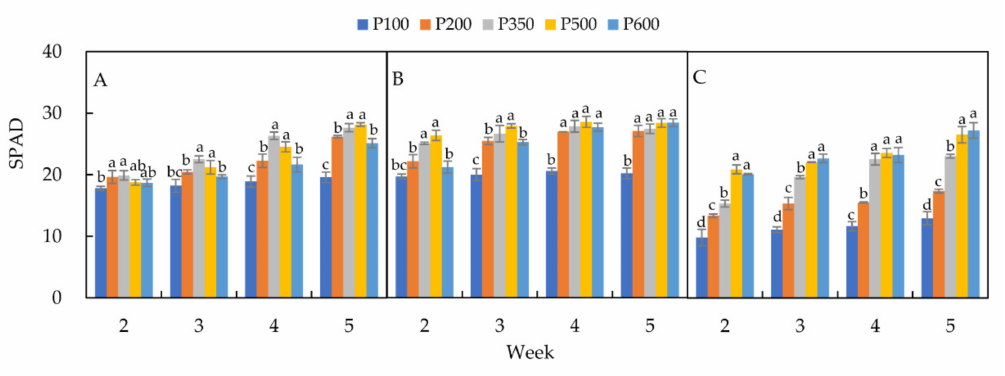
Figure 4. Chlorophyll content (SPAD) under different temperature and light conditions. Mean values with standard error of mean ( n = 3). ( A – C ) represented T15, T23, and T30, respectively. Letters indicate significant differences at p < 0.05 according to the LSD test.